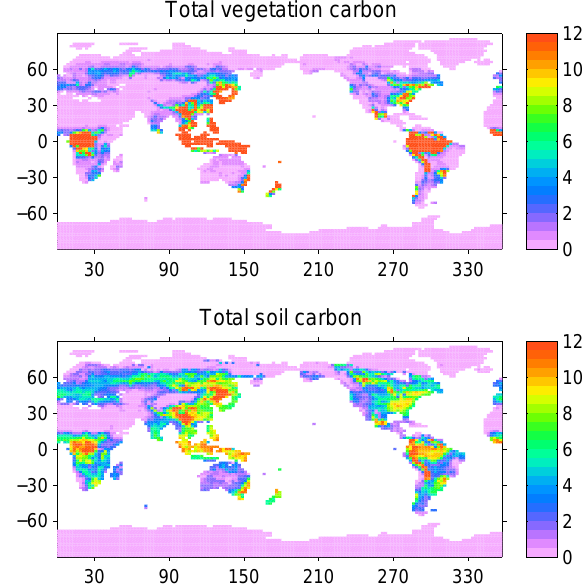
Fig. 15. Maps of mean (top) vegetation and (bottom) soil carbon contents as simulated by the NorESM model. Values are computed over the historical simulation from 1982–2005 period. Units are in (kgCm − 2 ).